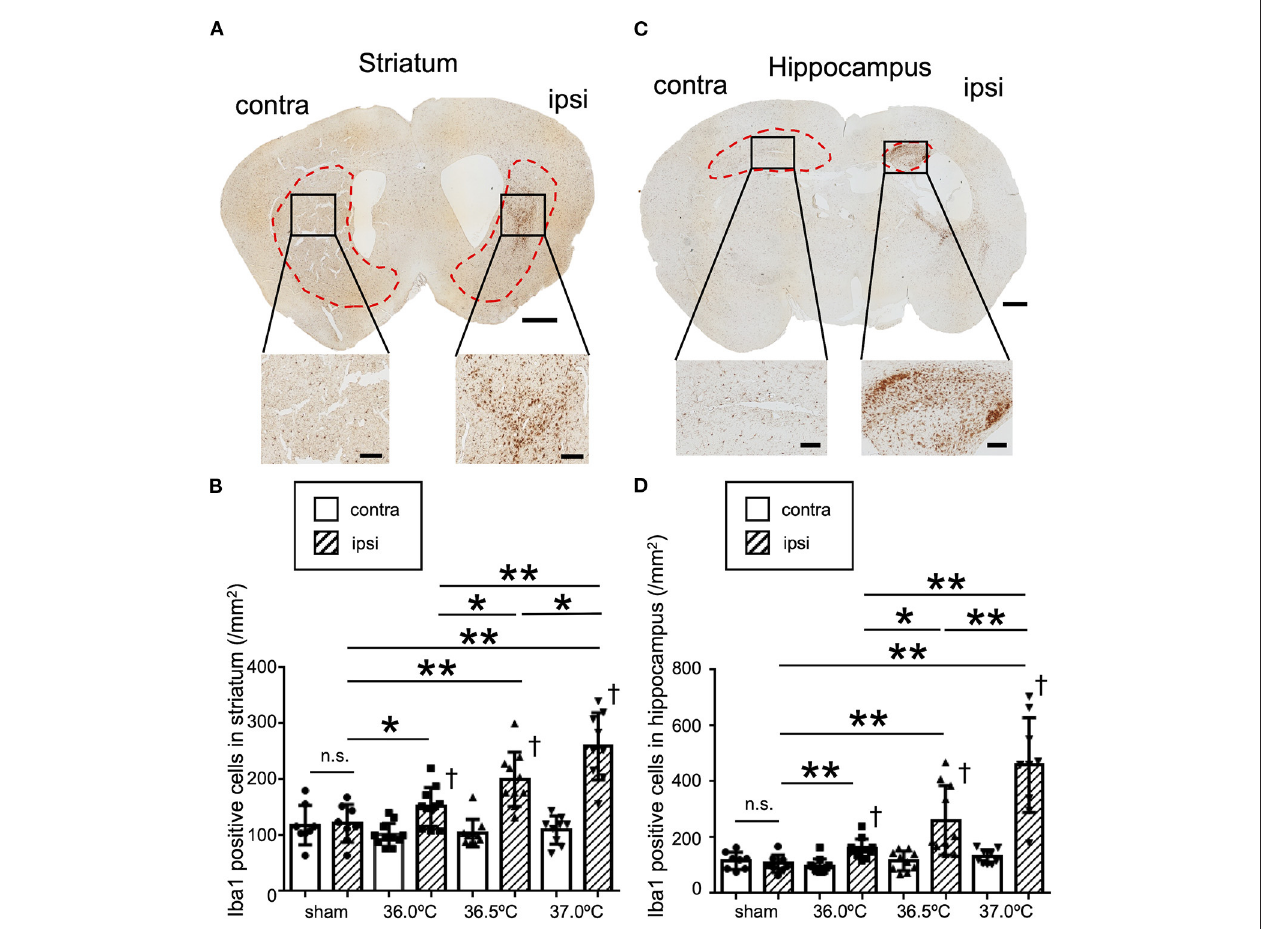
FIGURE 4 | Differences in Iba1 staining due to ambient temperature in HIE mice. (A) Iba1 staining in striatal section 14 days after hypoxia at 37.0 ◦ C. Red dotted lines show the striatal area. Lower panels show enlarged images of each black square in upper panel. Scale bar = 500 µ m in upper panel. Scale bars are 100 µ m in lower panels. (B) The number of Iba1-positive cells in the ipsi- and contra-lateral striatum 14 days after hypoxia at a temperature of 36.0, 36.5, or 37.0 ◦ C. (C) Iba1 staining in hippocampal section 14 days after hypoxia at 37.0 ◦ C. Red dotted lines show the hippocampal area. Lower panels show enlarged images of each black square in the upper panel. Scale bar = 500 µ m in upper panel. Scale bars are 100 µ m in lower panels. (D) The number of Iba1-positive cells in the ipsi- and contra-lateral hippocampus 14 days after hypoxia at temperatures of 36.0, 36.5, or 37.0 ◦ C. (sham, •, n = 8; 36.0 ◦ C, (cid:4) , n = 11; 36.5 ◦ C, N , n = 10; 37.0 ◦ C, H , n = 9). * p < 0.05, ** p < 0.01 against the ipsi side of another group. † p < 0.01 against the contra side. n.s.: not significant. Error bars show means + SD. Ipsi, ipsilateral; contra,